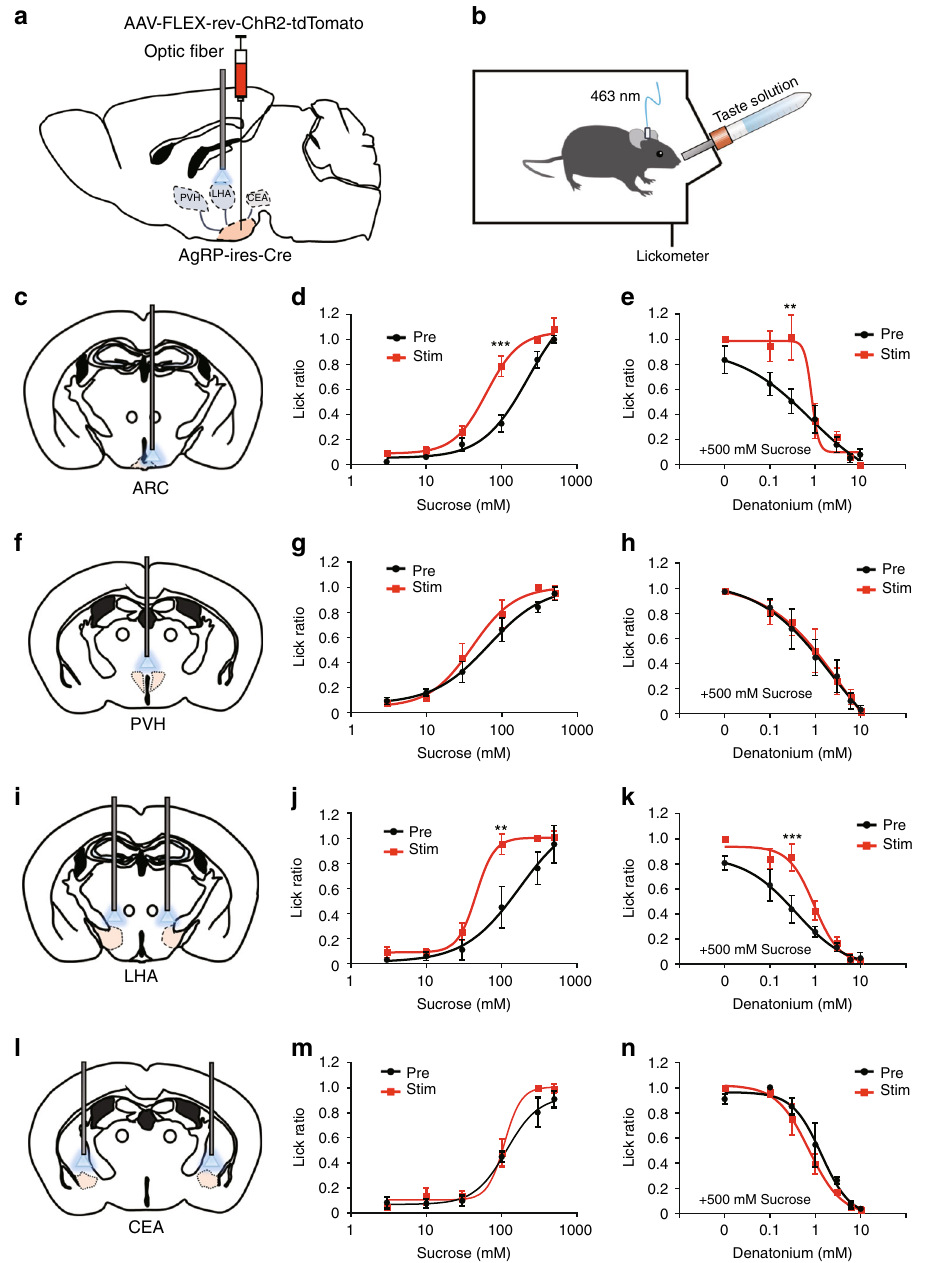
Fig. 2 Optogenetic activation of LHA-projecting AgRP neurons modulates taste preferences. a AAV-FLEX-rev-ChR2-tdTomato was bilaterally injected into the ARC of AgRP-ires-Cre mice, and optical fi bers were placed above the projection regions of AgRP neurons. b Schematic image of the brief access taste test during in vivo optogenetic activation of AgRP axon terminals in AgRP-ChR2 mice. c – e Brief access taste tests toward sweet ( d ) or bitter ( e ) solutions during photostimulation of the soma of AgRP ARC neurons. n = 11, F = 19.41, and P = 2.8 × 10 – 5 in d and n = 11, F = 6.926, and P = 0.01 in e , two-way ANOVA with Bonferroni post hoc test. f – n Brief access taste tests for sweet and bitter solutions when exclusively activating PVH-projecting ( f – h ), LHA- projecting ( i – k ), and CEA-projecting ( l – n ) AgRP neurons, respectively. n = 6, F = 2.263, and P = 0.138 in g , n = 6, F = 0.2445, and P = 0.87 in h , n = 5, F = 11.42, and P = 0.0015 in j , n = 5, F = 13.88, and P = 0.0005 in k , n = 5, F = 3.174, and P = 0.081 in m , and n = 5, F = 1.729, and P = 0.194 in n , two-way ANOVA with Bonferroni post hoc test. All experiments were carried out with 10- to 16-week-old male mice. Data are given as means ± SEM. * P < 0.05, ** P < 0.01, *** P < 0.001, as compared with the corresponding control group Vglut2 LHA neurons are a downstream target of AgRP neurons . the LHA led to an increase in food intake 23,24 . These results AgRP neurons are GABAergic and thus send inhibitory input into prompted us to investigate a possible connection between AgRP their downstream targets 22 . In the LHA, there are two types of neurons and Vglut2 LHA neurons. To con fi rm this connection, we fi rst injected AAV-Flex-tdTomato into the LHA of Vglut2-ires- neurons: GABAergic and glutamatergic. While arti fi cial inhibition of the vesicular GABA transporter (Vgat)-expressing neurons in Cre mice for labeling (Fig. 4a). We observed that tdTomato- the LHA led to a decrease in food intake, arti fi cial inhibition of the positive Vglut2 neurons and the axon terminals of AgRP neurons vesicular glutamate transporter2 (Vglut2)-expressing neurons in are in close proximity to each other in the LHA (Fig. 4a). NATURE COMMUNICATIONS| (2019) 10:4560